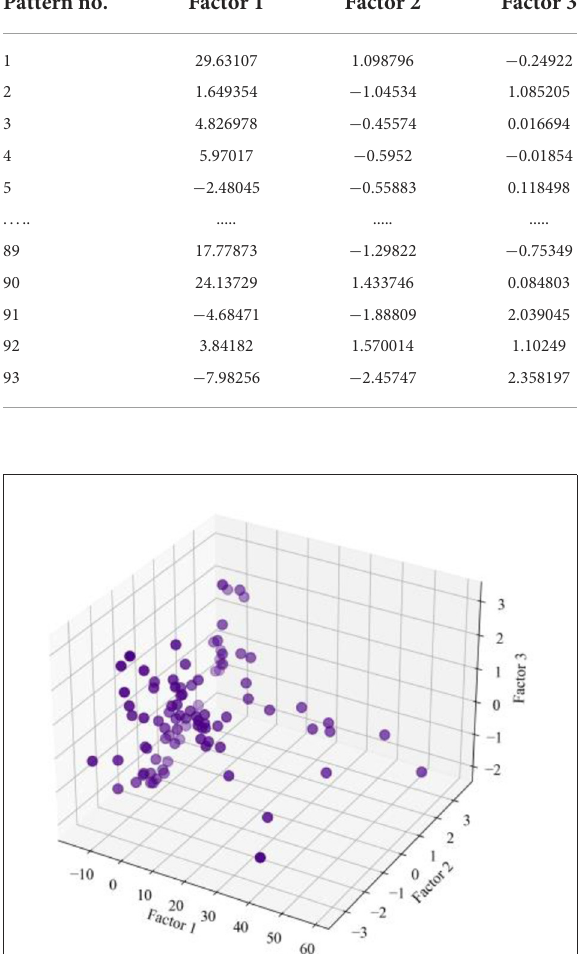
TABLE 3 The influential factor of rockburst dataset acquired from isomap. Pattern no.